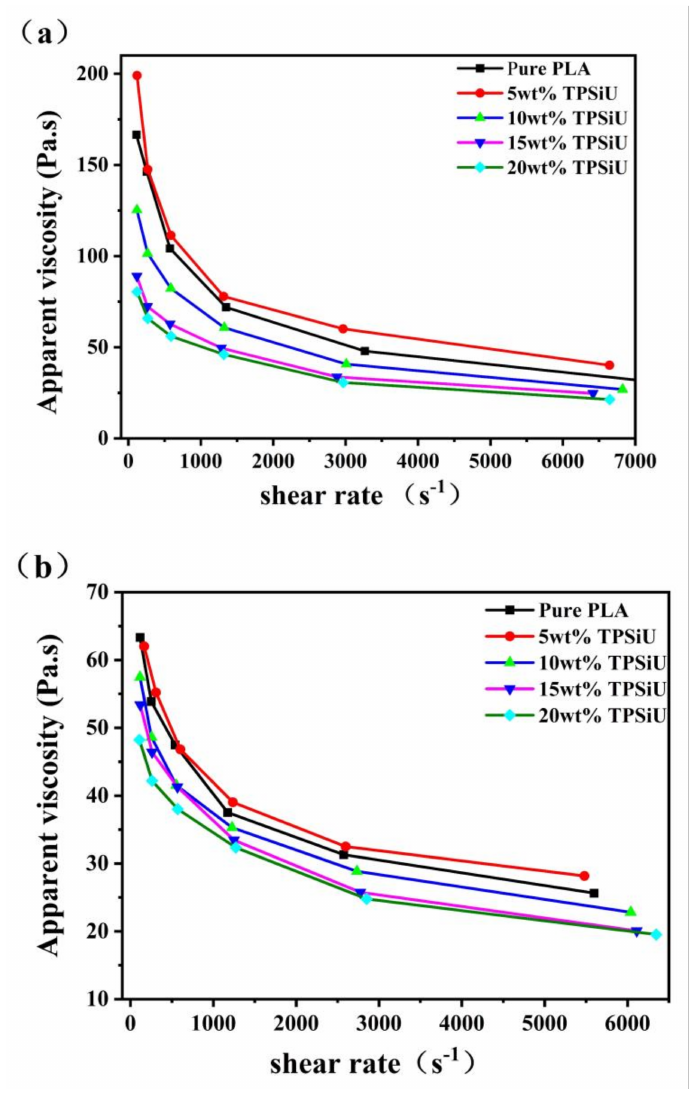
Figure 13. Apparent viscosity-shear rate curves of PLA/TPSiU blends, ( a ) 230 ◦ C, ( b ) 240 ◦